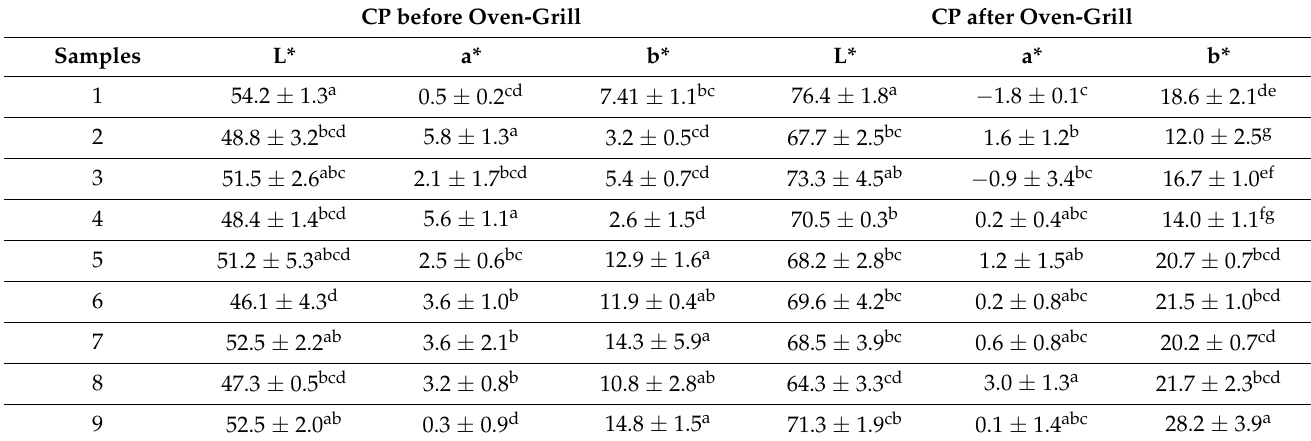
Figure 6. Changes in cooking weight loss (%) across the various marinated oven-grilled chicken breast meat samples compared to the control. Results are expressed as mean ± standard deviation (SD) at the probability level of p < 0.05. The numbers representing different color shades are as follows: (1) control (antioxidant additive % = 0.0); (2) control (antioxidant additive % = 0.5); (3) control (antioxidant additive % = 1.0); (4) control (antioxidant additive % = 1.5); (5) AS (antioxidant additive % = 0.0); (6) AS (antioxidant additive % = 0.5); (7) AS (antioxidant additive % = 1.0); (8) AS (antioxidant additive % = 1.5); (9) IM (antioxidant additive % = 0.0); (10) IM (antioxidant additive % = 0.5); (11) IM (antioxidant additive % = 1.0); (12) IM (antioxidant additive % = 1.5). African spice: AS; and industrial marinade/pickle: IM. Table 3. (a–c) Changes in L* a* b* color across the various marinated oven-grilled chicken breast meat samples incorporating (a) cranberry pomace (CP), (b) grape pomace (GP), and (c) Baikal skullcap (BS) compared to the